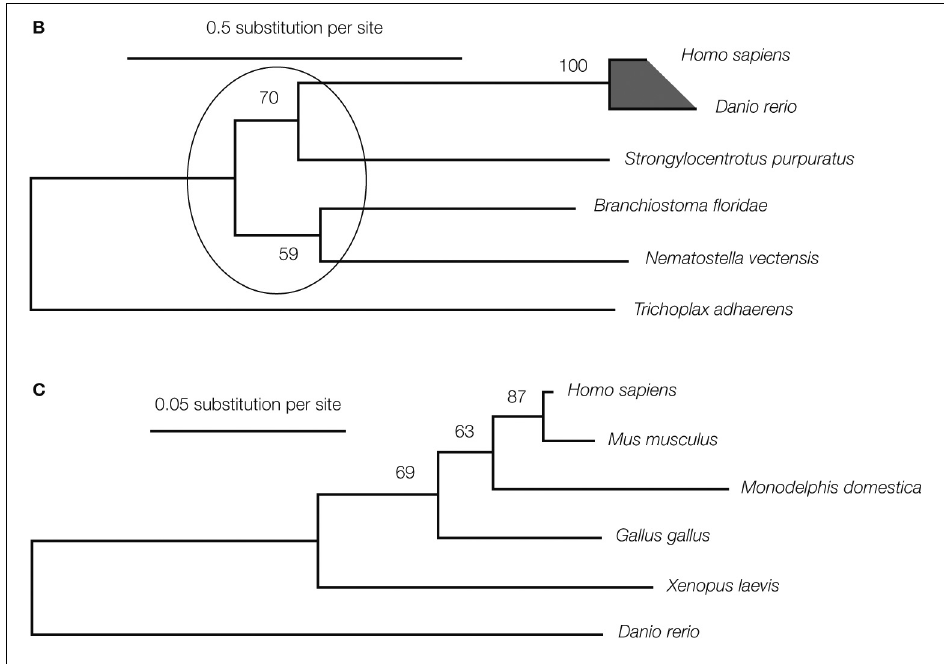
Figure 1 | Molecular phylogenetic studies of the kf-1 gene. (B) The molecular phylogenetic tree for animal KF-1. The tree is inferred by the genetic algorithm-based maximum likelihood method (Katoh et al., 2001). The evolutionary rate heterogeneity among the sites was taken into account by assuming Yang’s discrete gamma model (Yang, 1994) and an optimized shape parameter alpha of 1.93. Highly homologous sites without gap sites (404 amino acid sites) were selected for the comparison as indicated by asterisks in (A) . The numbers at each branching node represent the bootstrap probability. The branching orders within the ellipse are not signifi cant. The shaded region is expanded in (C) for vertebral KF-1. GI numbers are given in (A) . (C) The maximum likelihood tree for vertebral KF-1, which corresponds to the shaded region in (B) . Highly homologous sites without gap sites within the vertebrate sequences (580 amino acid sites; not shown) were used for tree inference. The optimized shape parameter alpha is 0.43. The numbers at the branching nodes are the bootstrap probabilities. GI numbers are given in (A) for H. sapiens and D. rerio , and 2058263, 126305140, 71896439, and 20126691 for M. musculus , M. domestica , G. gallus , and X. laevis , respectively.